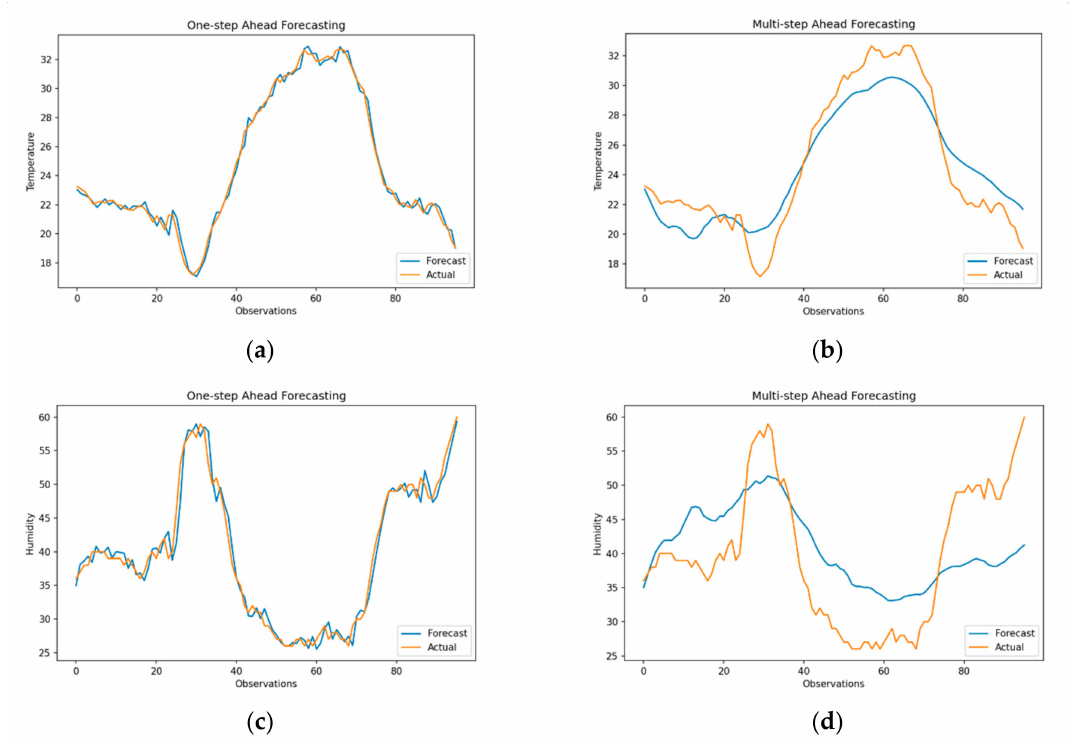
Figure 6. Forecast using Support Vector Regression (SVR) ( a ) One-step ahead Temperature ( RMSE = 0.478) ( b ) Multi- step ahead Temperature ( RMSE = 3.141) ( c ) One-step ahead Humidity ( RMSE = 2.168) ( d ) Multi-step ahead Humidity ( RMSE = 9.556) ( top-left, top-right, bottom-left, bottom-right